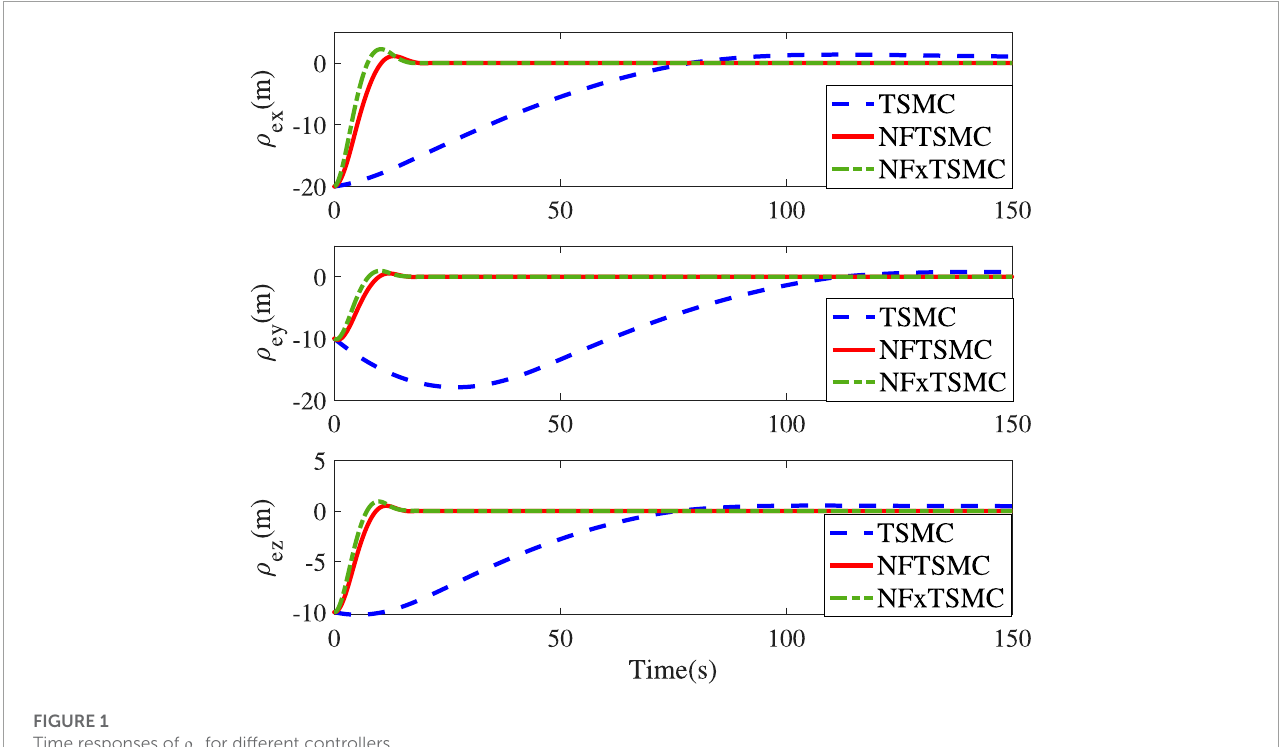
FIGURE 1 Time responses of ρ e for different controllers.